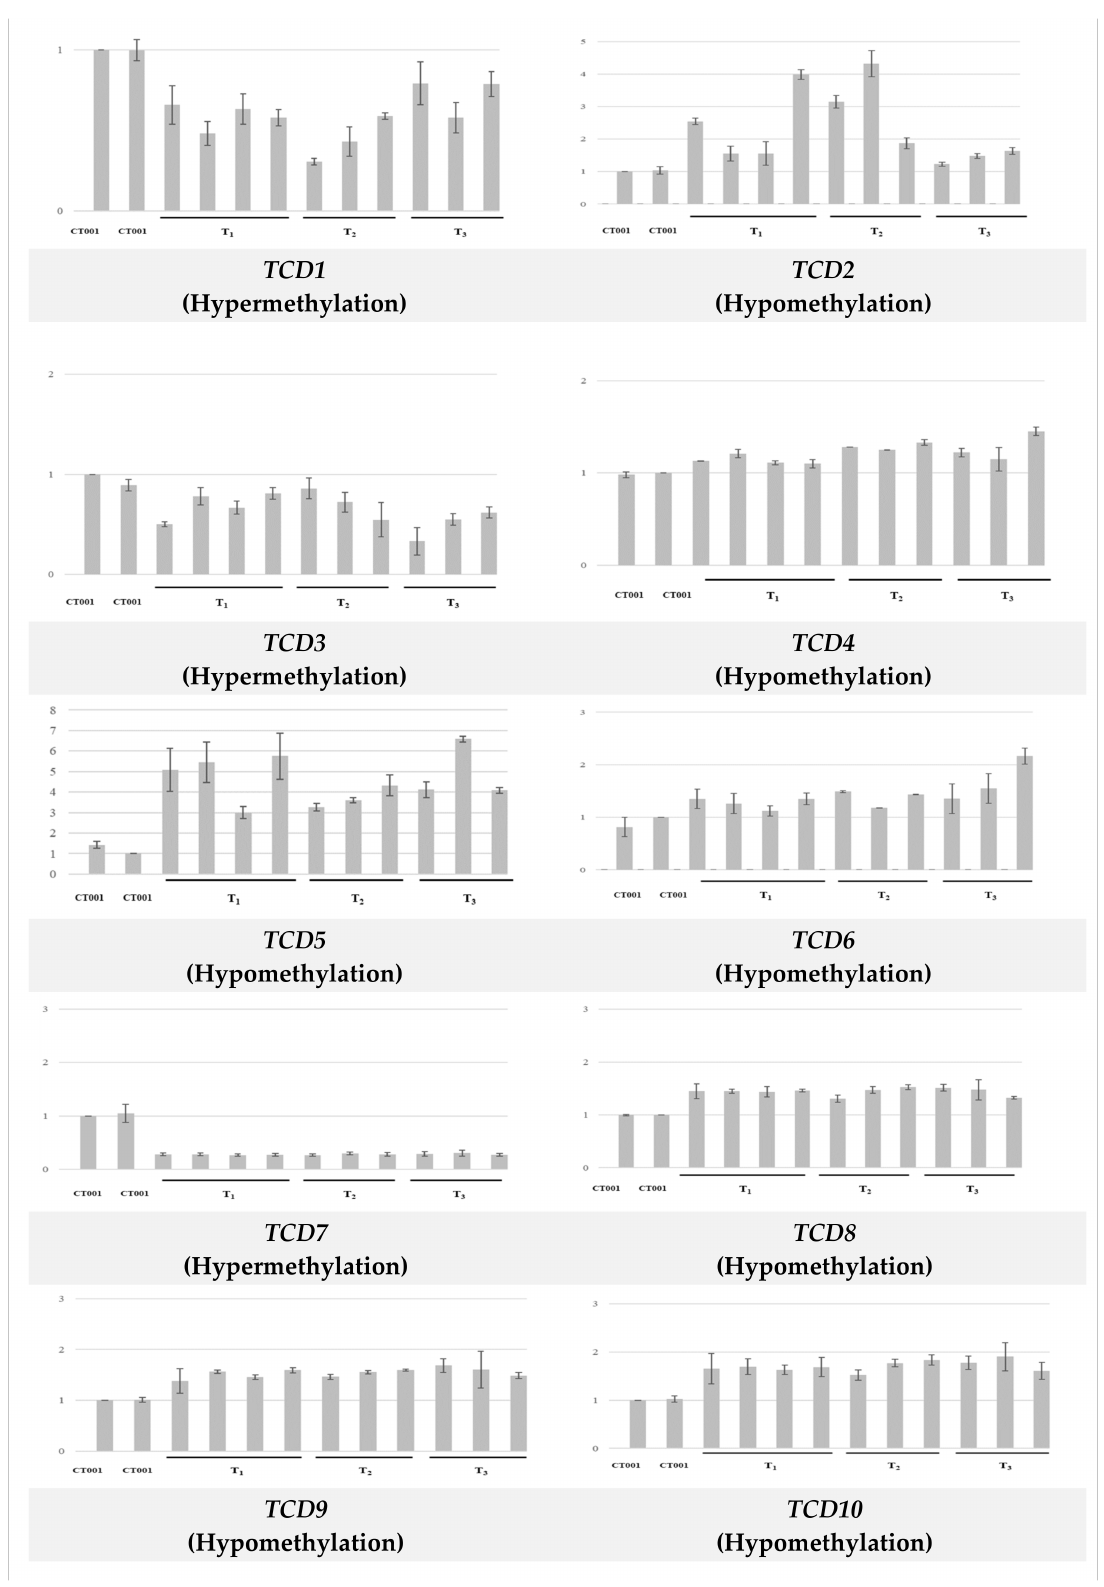
Figure 3. Gene expression analysis of 10 selected genes within transformant-conserved DMRs (TCDs) between the non- transgenic and transgenic lines. Expression levels of each DMR gene in T 1 , T 2 , and T 3 generations of IGA were compared with inbred line ‘CT001’. Y -axis indicates relative mRNA expression, and bars on the graph indicate the SE of the means ( n =